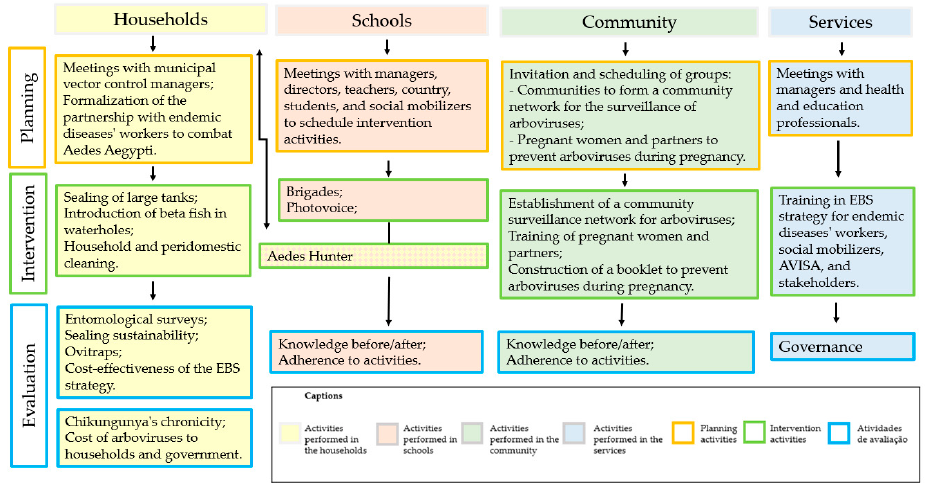
Figure 3. Flowchart of the developed activities.